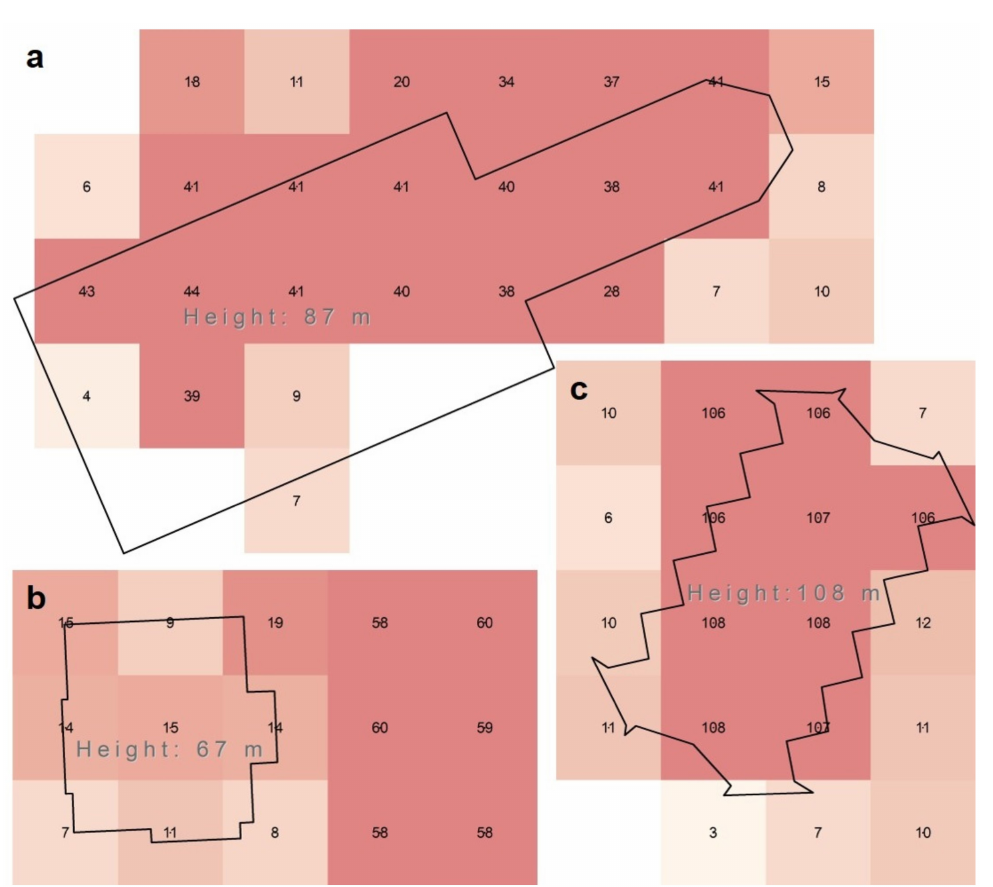
Figure 5. Validation examples: ( a ) St Martin’s Cathedral—height difference 43 m, ( b ) multifunctional building located on Krasovsk é ho Street 13—height difference 7 m with geolocation error, ( c ) Slovak Television